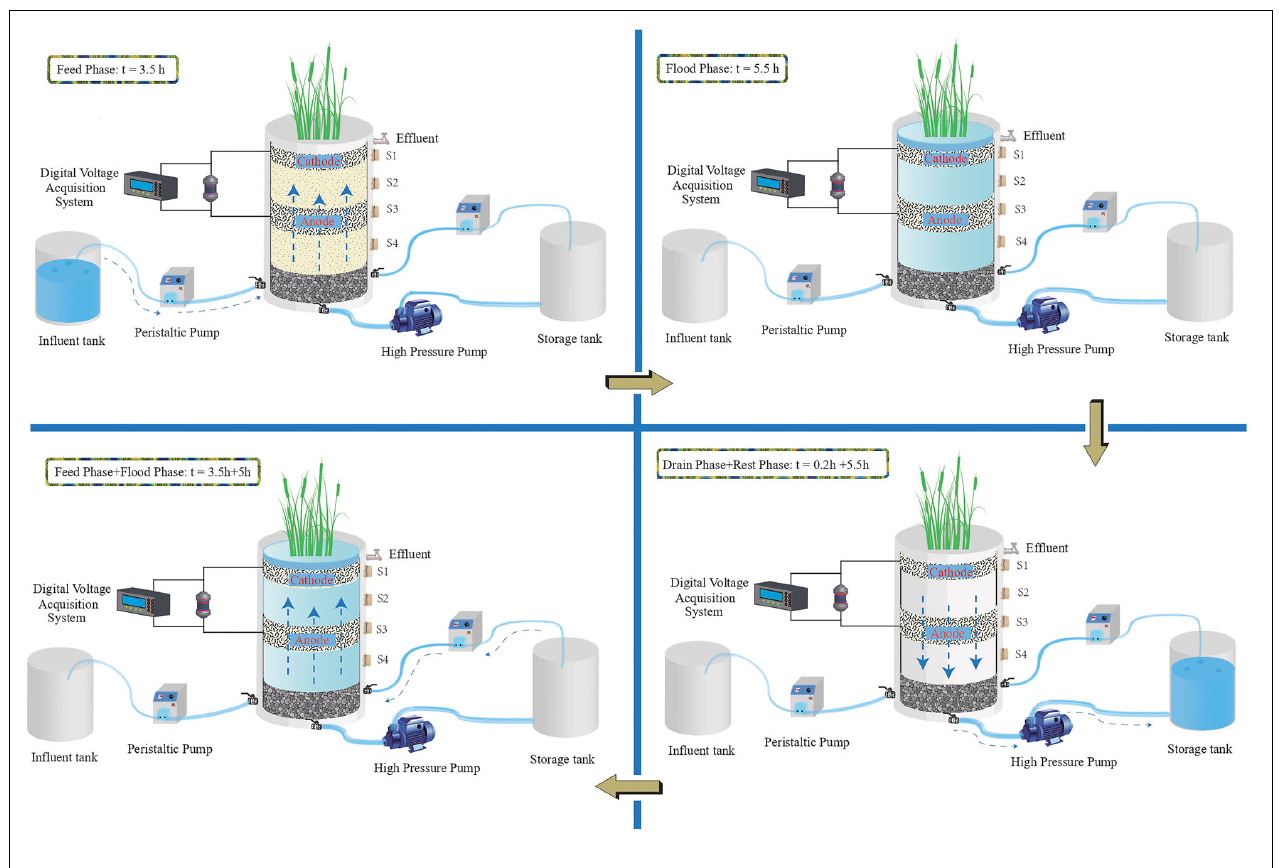
FIGURE 1 | Schematic diagram of TFCW-MFC during a typical cycle mode.